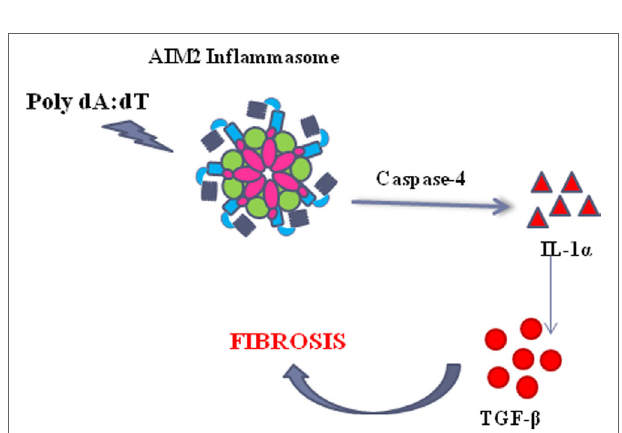
FigUre 7 | The activation of the absent in melanoma 2 (AIM2) inflammasome induce the release of caspase-4 which leads to IL-1 α release, responsible of TGF- β release in idiopathic pulmonary fibrosis- derived peripheral blood mononuclear